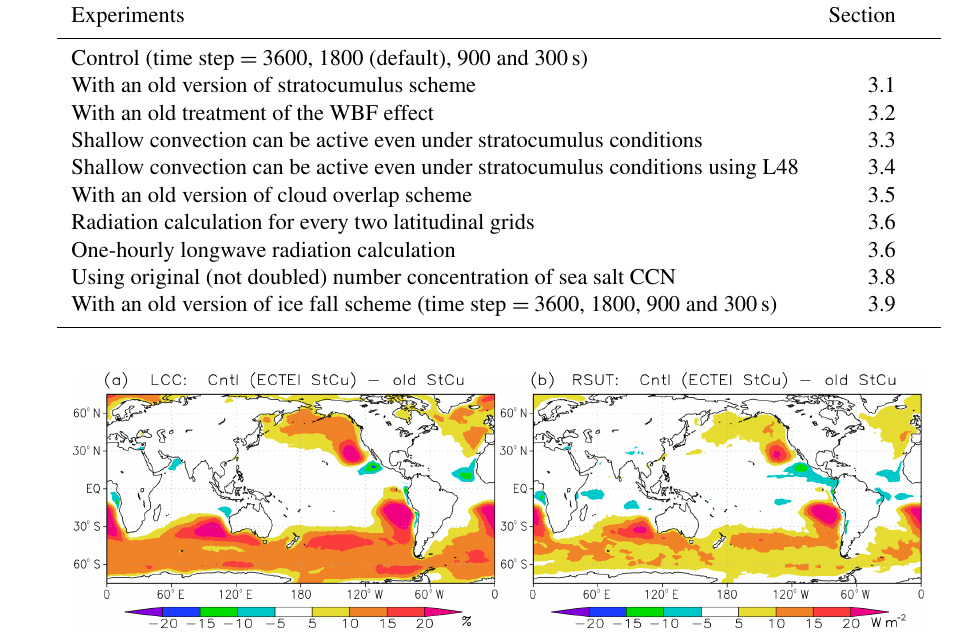
Figure 3. Impacts of the new stratocumulus scheme on (a) low-cloud cover (%) and (b) TOA upward shortwave radiative flux (Wm − 2 ) . The plots show results for the control model (with the new stratocumulus scheme) minus those for an experiment with an old version of the stratocumulus